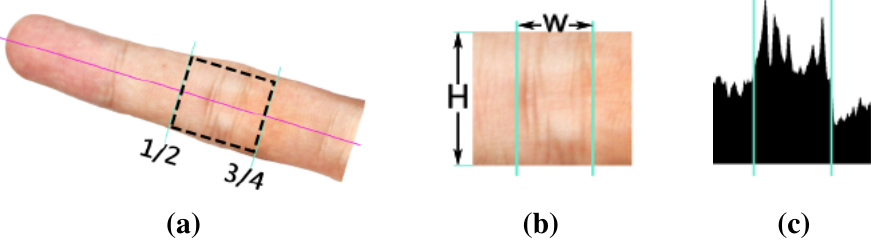
Figure 3. IKP ROI location: ( a ) ROI location; ( b ) normalization; ( c ) Radon